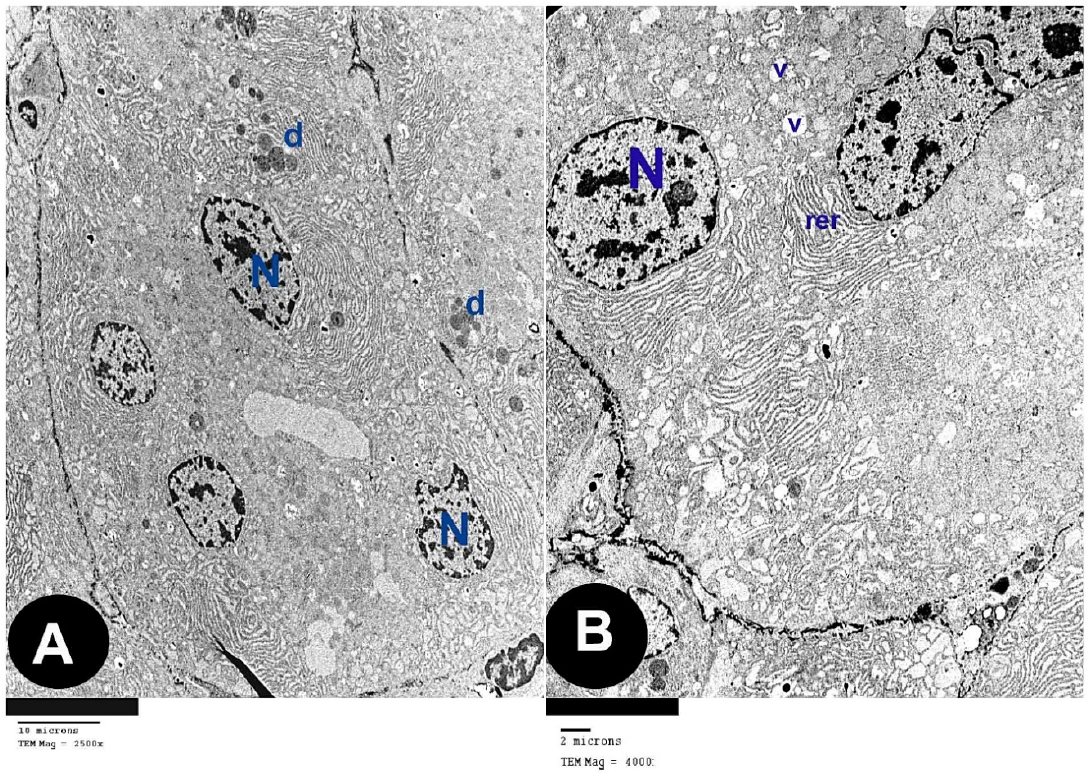
Figure 5. Electron microscope sections in parotid tissue of albino rats of the AOH+ Gallic acid group: ( A ) serous acini are lined with pyramidal-shaped cells with euchromatic nuclei (N) and small, dense granules (d). ( B ) Rough endoplasmic reticulum (rer). Few acinar cells have cytoplasmic vacuoles (v).